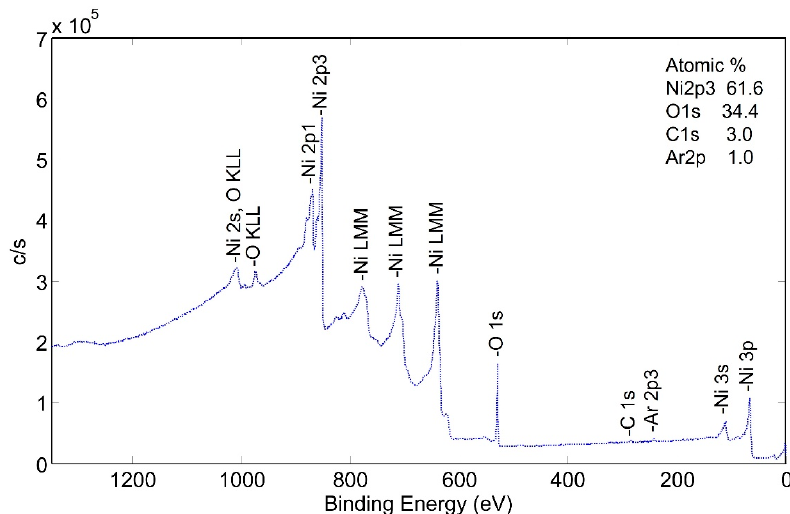
Figure 8. Wide scan XPS spectra for NPG heat treated at 425 °C (b-sample).